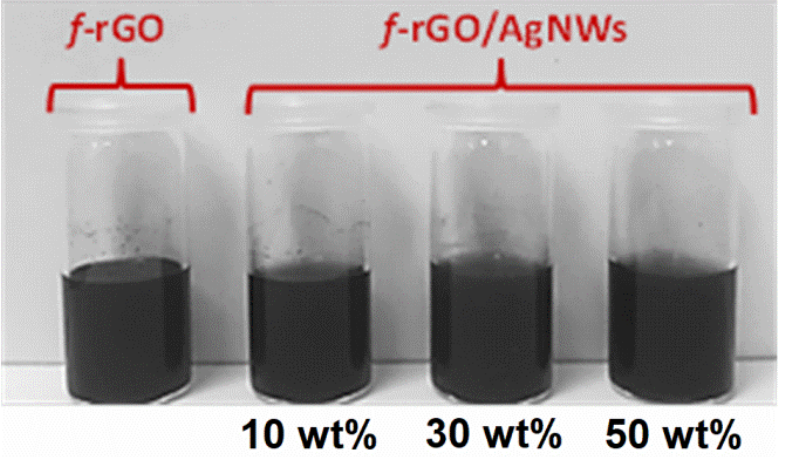
Figure 6. Indicative photo of f -rGO DBSA and f -rGO DBSA /AgNWs hybrid systems with three different metal loadings (10, 30, and 50 wt %) dispersed in water (1 mg/mL) after three months.